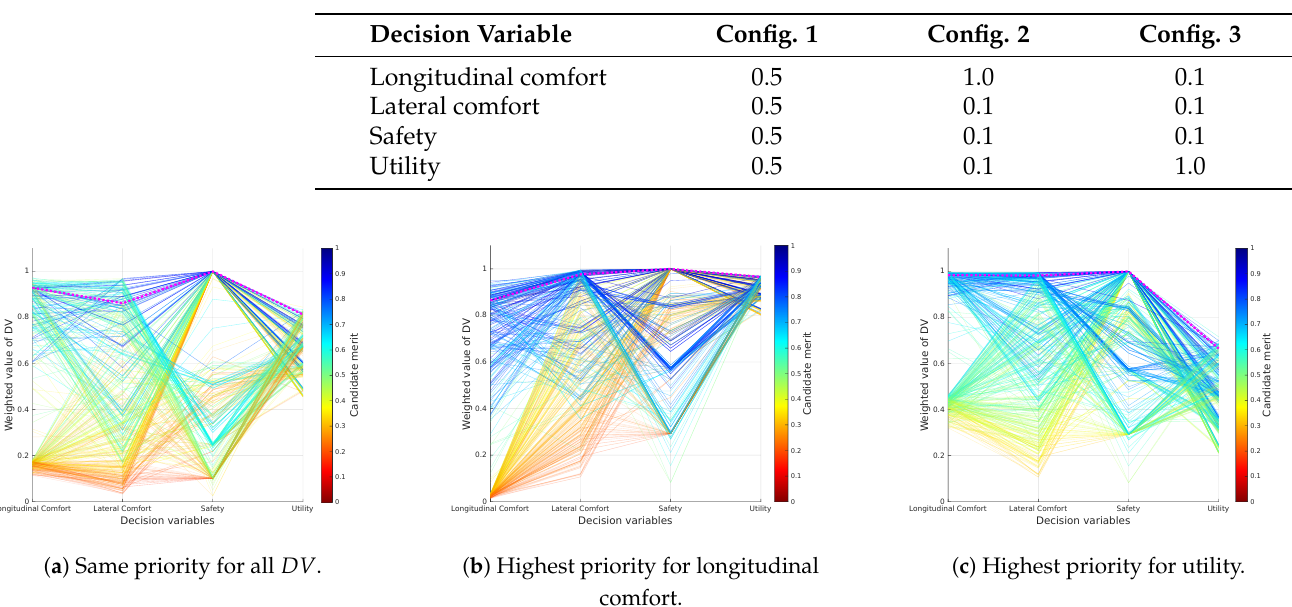
Table 2. Weight configurations of decision variables for use case scenario.